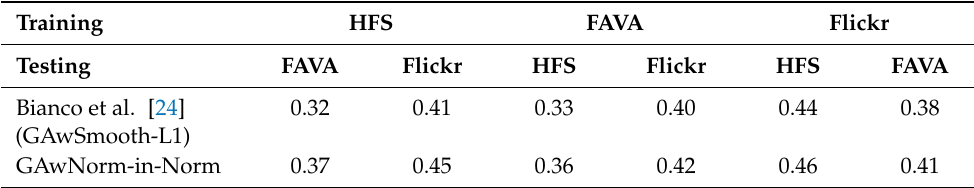
Table 6. Cross-database performance in terms of SROCC. Each entire database was used for both training and